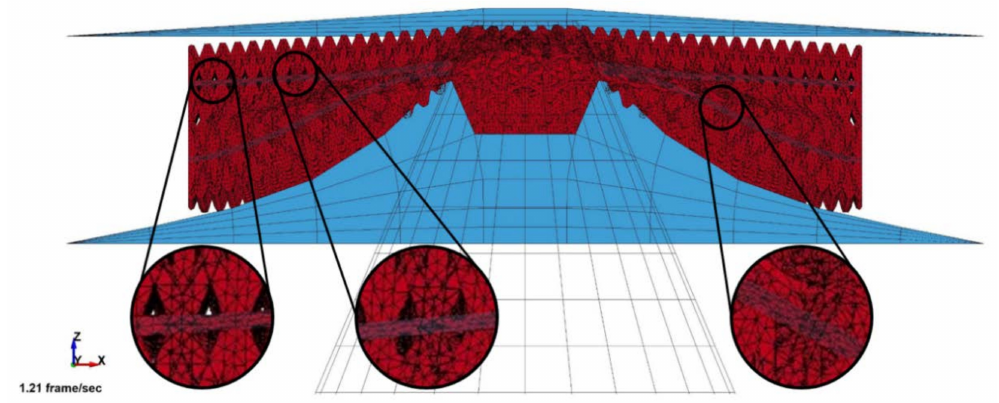
Figure 9. Section view of damage on the sandwich